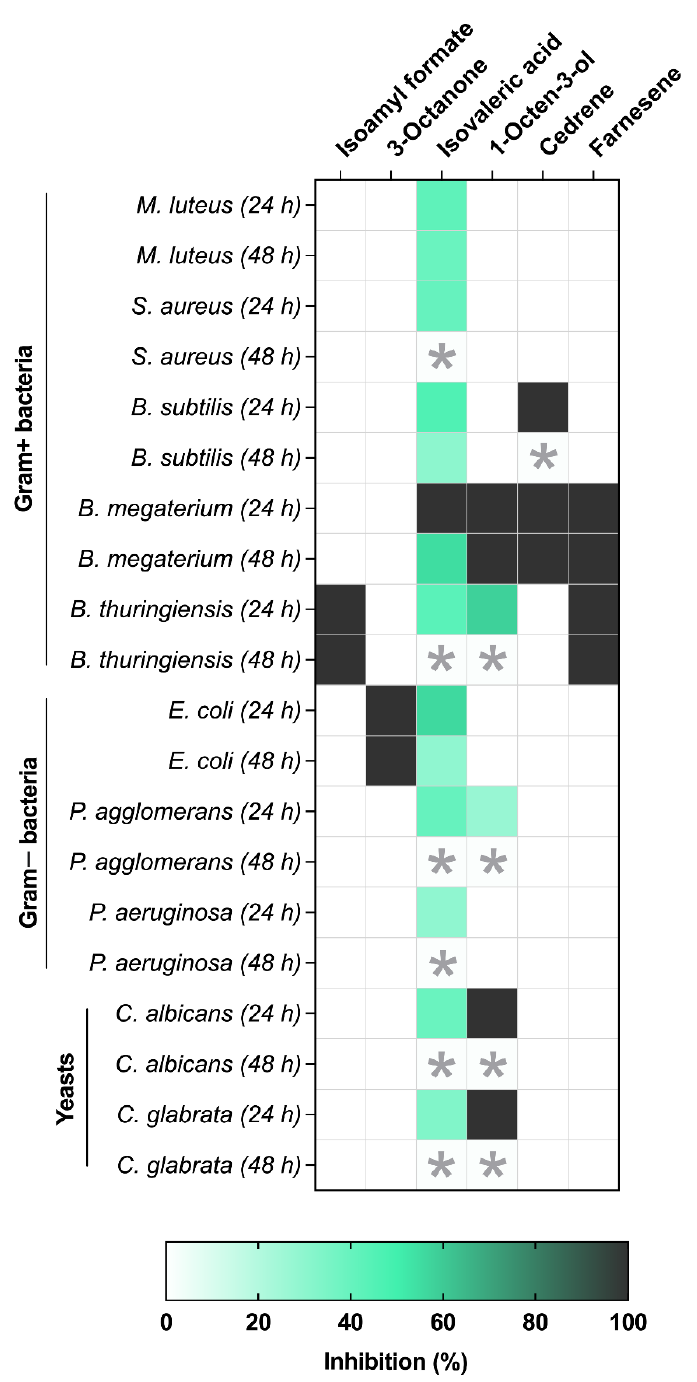
Figure 3. Growth inhibition (%) of bacteria and yeast exposed to volatile organic compounds. Microbial growth was recorded at 24 and 48 h post-exposure to 10 µL VOC. Values represent the mean (±SD) of two independent experiments, consisting of 4 technical replicates per treatment. An asterisk (*) denotes growth recovery.